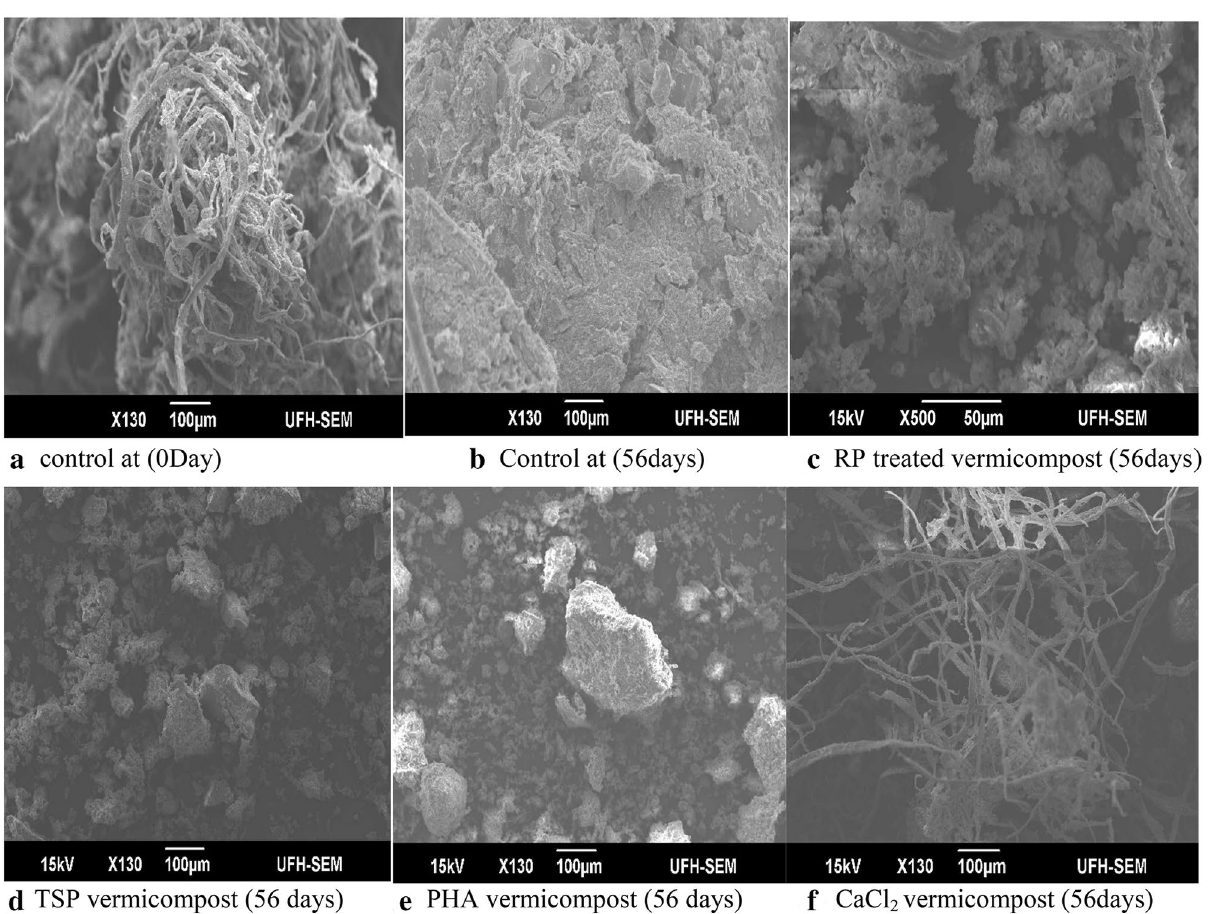
Fig. 6 Scanning electron microscope pictures showing P and Ca source effects on vermicompost morphological